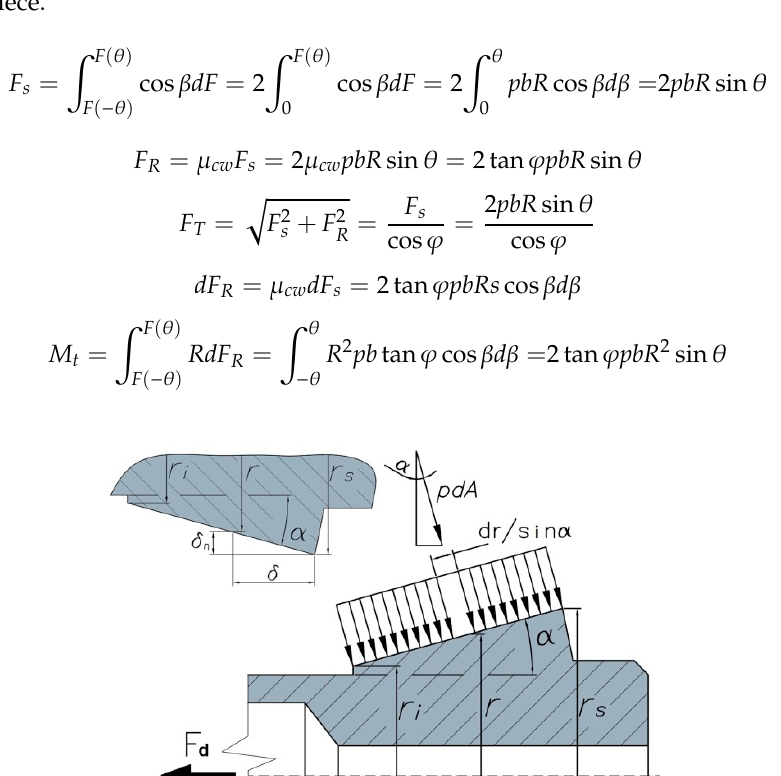
Figure 5. Components subjected to the maximum tensile stress.